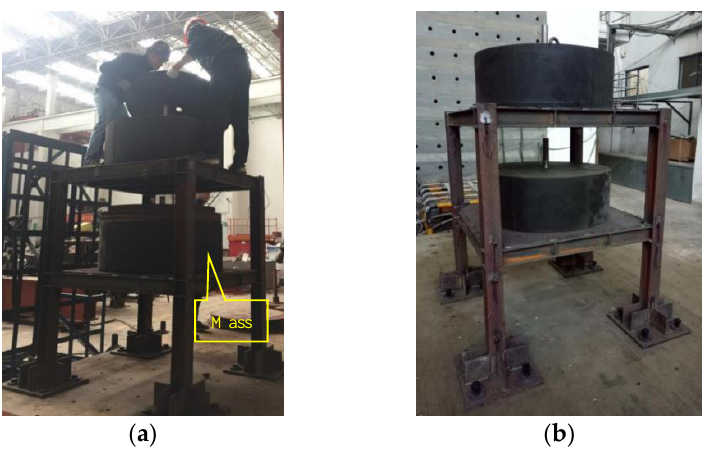
Figure 10. Installed specimen. ( a ) Placing mass block; ( b ) hoisting at the appropriate position.